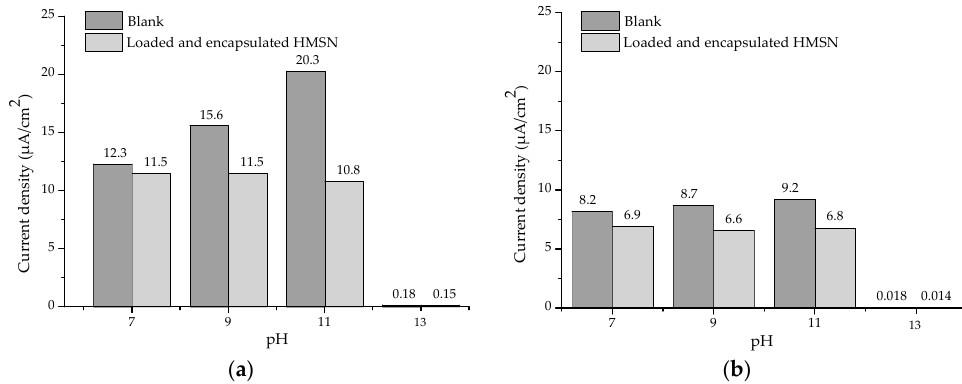
Figure 8. Current density as a function of pH obtained from Rp measurements: ( a ) After 30 min of exposure and ( b ) after 24 h of